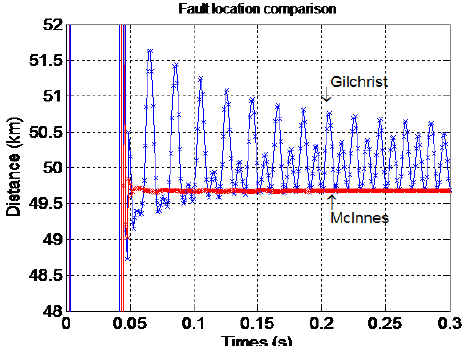
Fig. 12: Fault in transmission